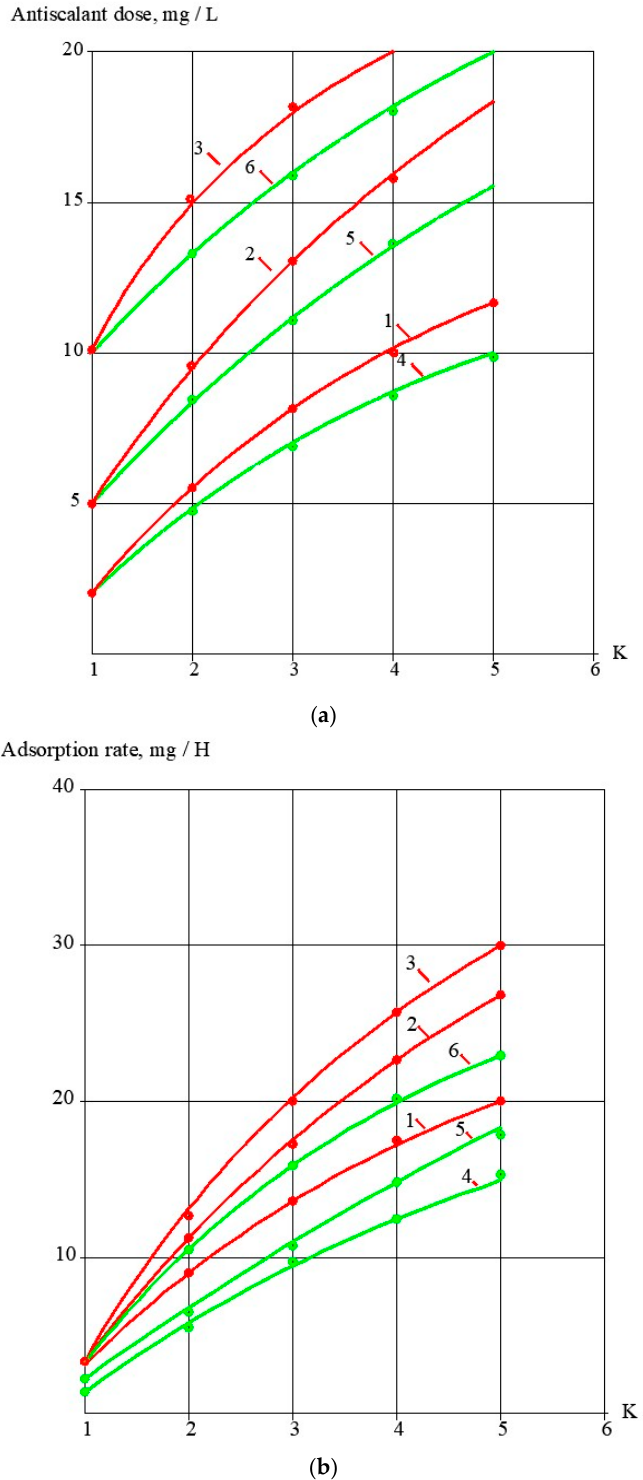
Figure 4. Dependencies of Aminat-K and Jurby-Soft doses in RO concentrate on K values ( a ) and dependencies of adsorption rate values on K ( b ): 1—Aminat -K, dose 2 ppm; 2—Aminat-K, dose 2 ppm; 3—Aminat-K, dose 10 ppm; 4—Jurby-Soft, 2 ppm; 5—Jurby-Soft, 5 ppm; 6—Jurby-Soft, 10